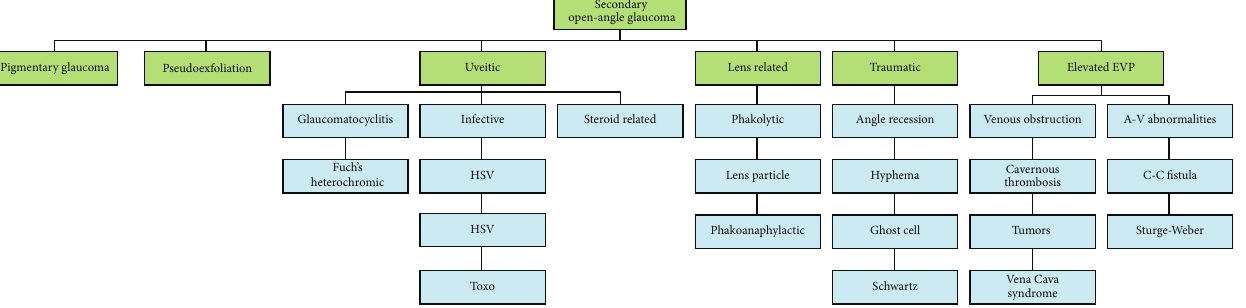
Figure 2: Secondary open-angle glaucoma classification